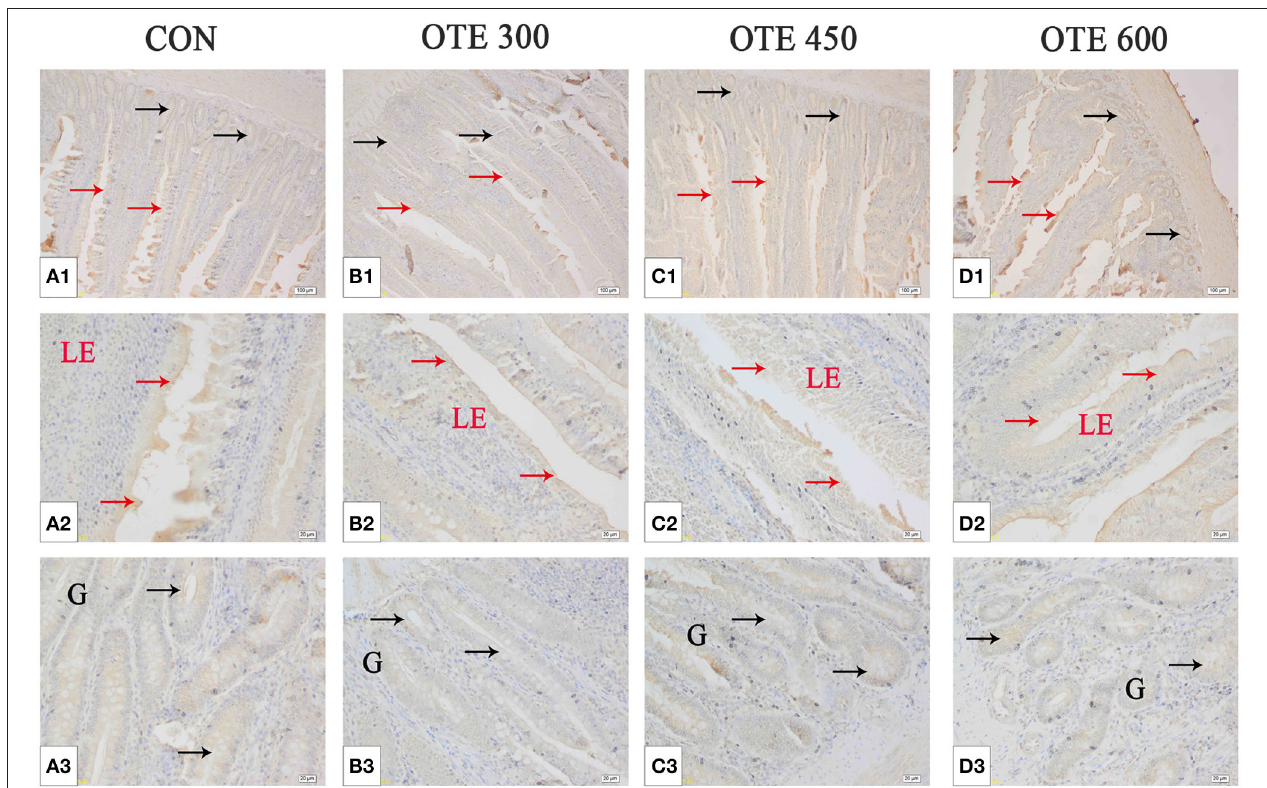
FIGURE 3 | Effects of organic trace elements supplementation on zinc transporter 1 (ZnT-1) localization in duodenum of late-phase laying hens. (A–D) Represent the control, 300, 450, and 600 mg/kg organic trace elements, respectively. Scale bars were 100 µ m (A1–D1) and 20 µ m (A2–D2,A3–D3) . The red arrow represents ZnT-1 immunopositive cells in the duodenal villi, and the black arrow represents ZnT-1 immunopositive cells in the duodenal gland ( n =